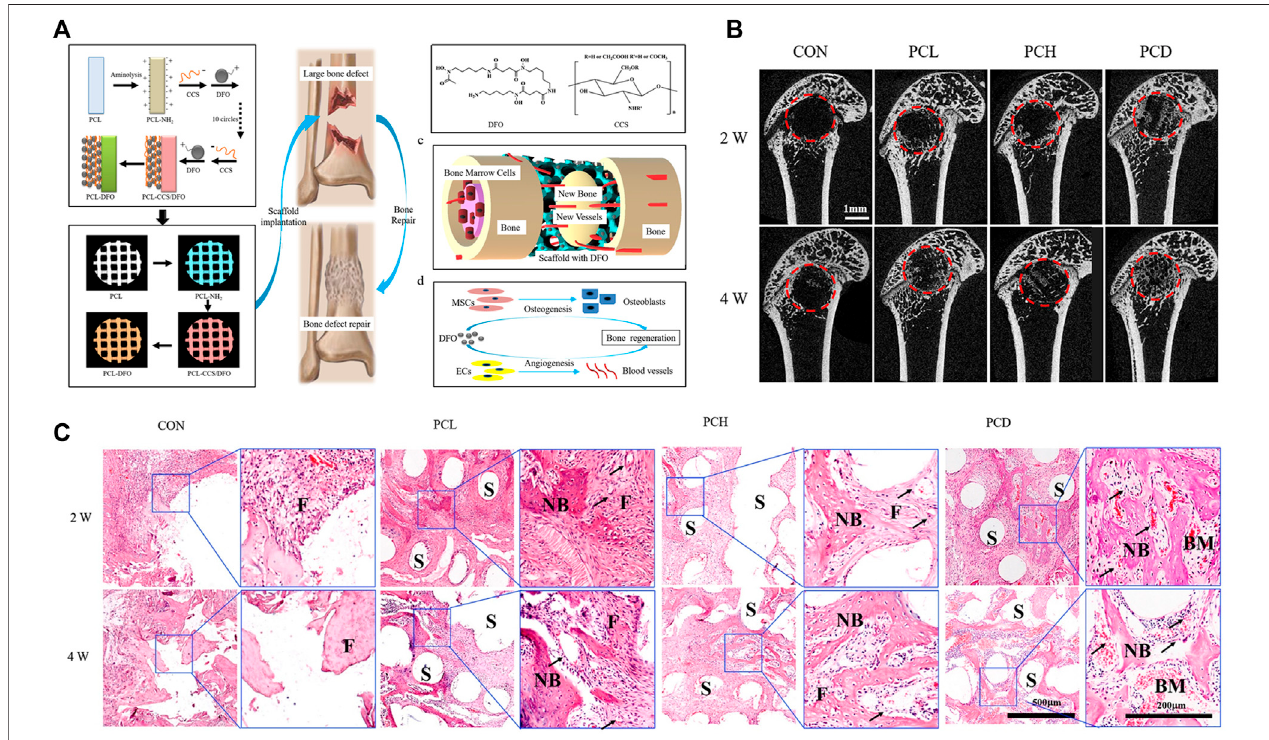
FIGURE7| Vascularized3Dprintedscaffoldsforpromotingboneregeneration. (A) Schematicdiagramofbridgingdeferoxamine(DFO)onthesurfaceof3Dprinted polycaprolactone (PCL) scaffold and its biological function for bone regeneration in bone defect model; (B) Micro-CT analysis of the effect of scaffolds on bone repair in vivo ; (C) Representativeimagesofhematoxylin-eosin(HE)stainingofthedecalci fi catedbonesslice,showingthenewformedtissueincludingthe fi broustissue(F),newly mineralized bone tissue (NB) and the structure of scaffolds (S). Copyright 2019